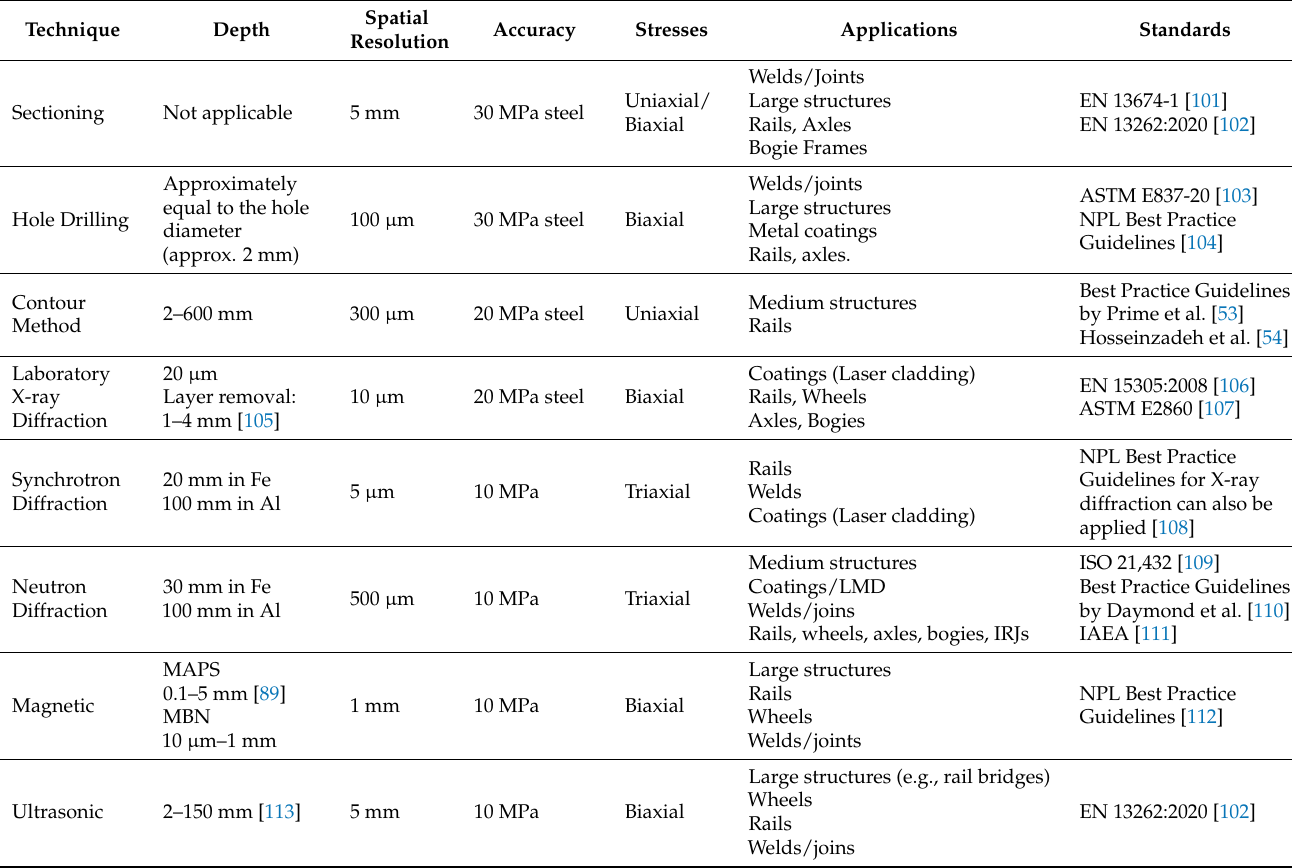
Table 3. Comparison of Physical Characteristics of Residual Stress Measurement Technique.